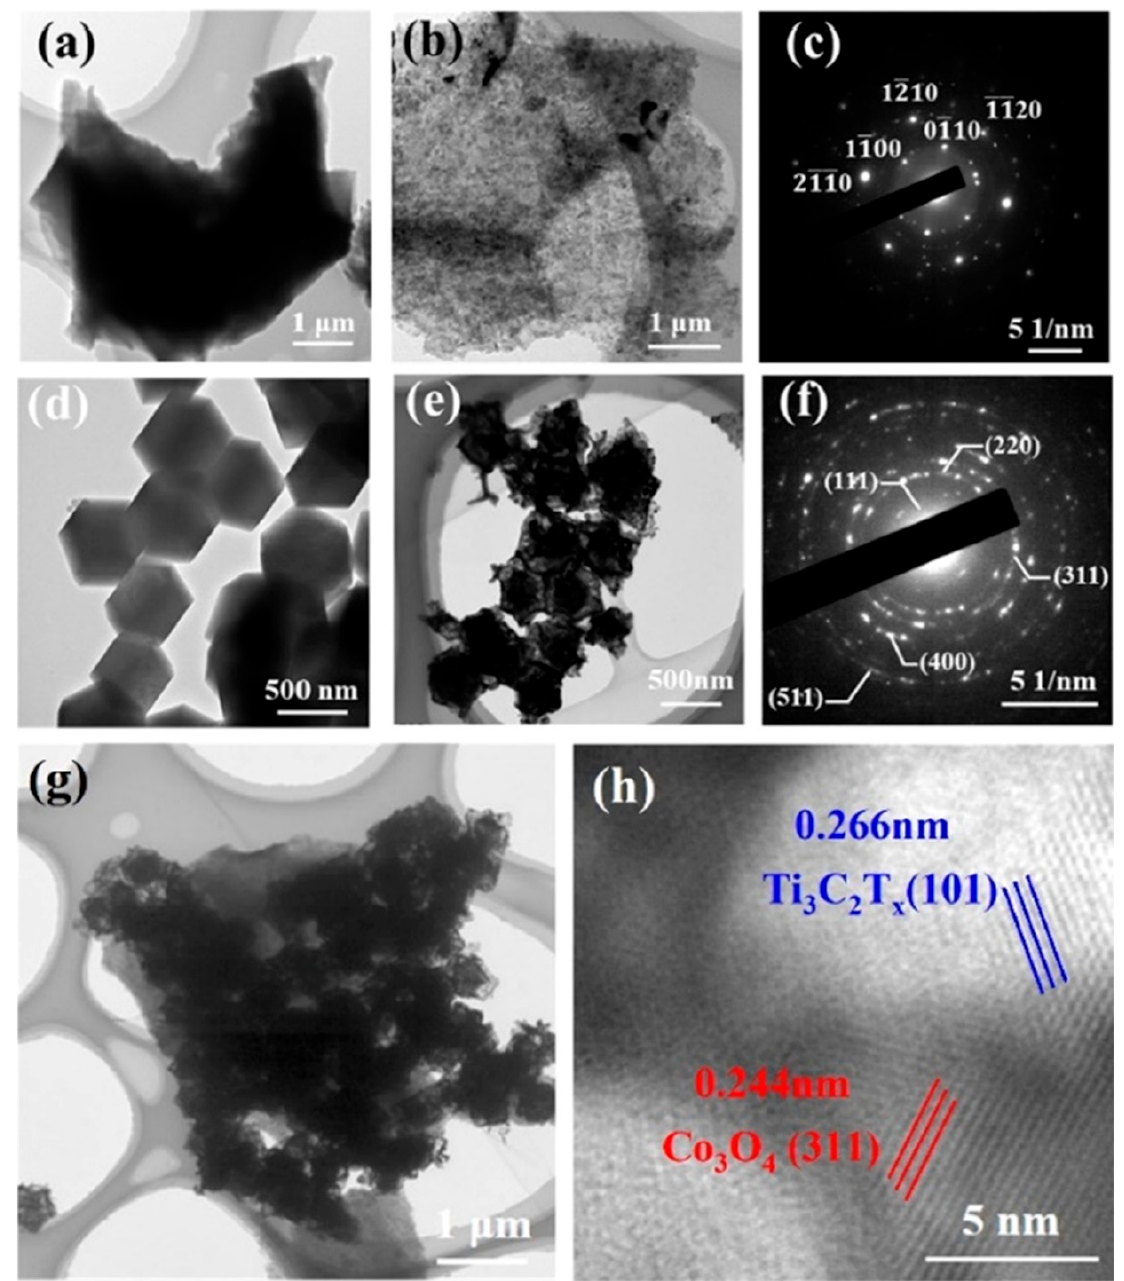
Figure 32. TEM images of ( a ) multi-layer Ti 3 C 2 T x and ( b ) Ti 3 C 2 T x nanosheets, ( c ) SAED image of Ti 3 C 2 T x , TEM image of ( d ) ZIF-67 and ( e ) Co 3 O 4 , ( f ) SAED image of Co 3 O 4 , and ( g ) TEM image of Co 3 O 4 /Ti 3 C 2 T x -2% nanocomposite. ( h ) HRTEM image of Co 3 O 4 /Ti 3 C 2 T x -2%. Reprinted with permission from [144]. Copyright 2022: Elsevier B.V.